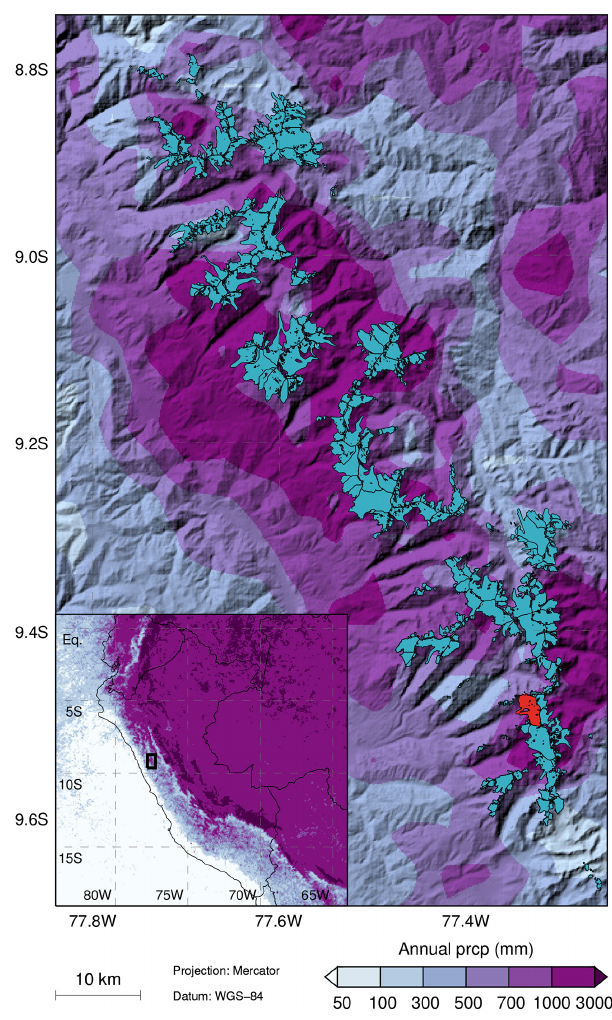
Figure 1. Map of the Cordillera Blanca with glacier outlines from the Randolph Glacier Inventory (Arendt et al., 2014). The Shallap Glacier is colored in red. Color contours: 1998–2009 annual rainfall climatologies (mm) at ∼ 5km resolution provided by Bookhagen and Strecker (2008)